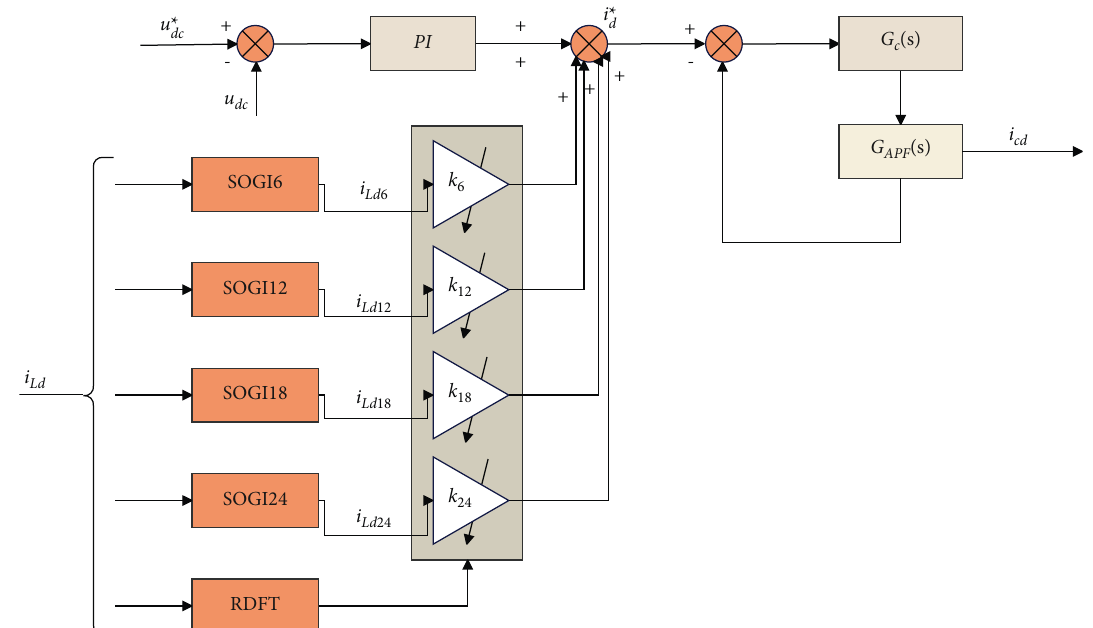
Figure 8: Block diagram of adaptive compensation control of d -axis harmonic